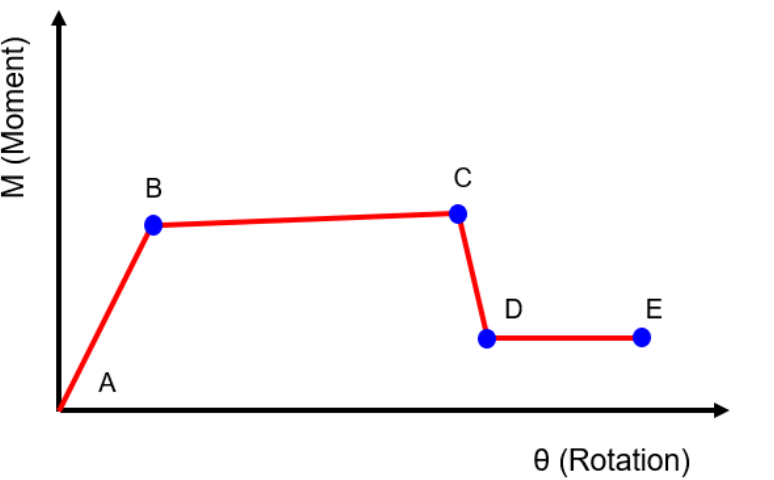
Figure 4. Typical moment–rotation curve for reinforced concrete according to ASCE 41 [23]. Concrete moment frames with 2, 4, 8, 12, 16, 20, and 24 story levels were loaded laterally with different patterns according